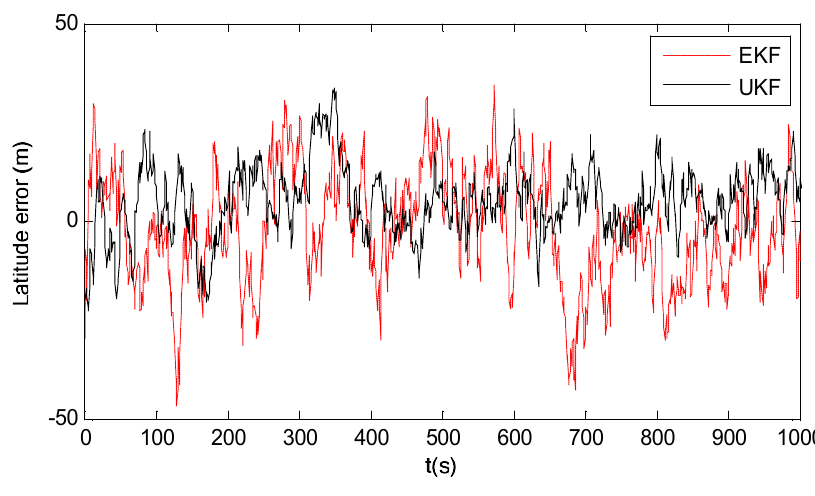
Figure 12. Latitude errors of EKF and UKF.